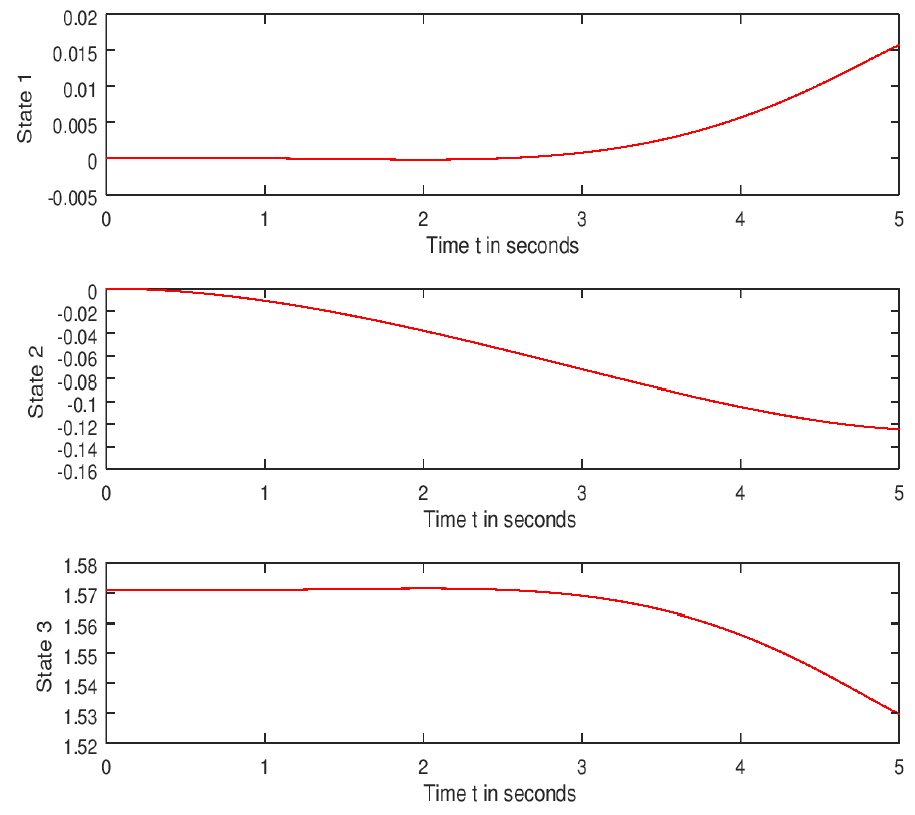
Figure 11. Feasible first three state trajectories.